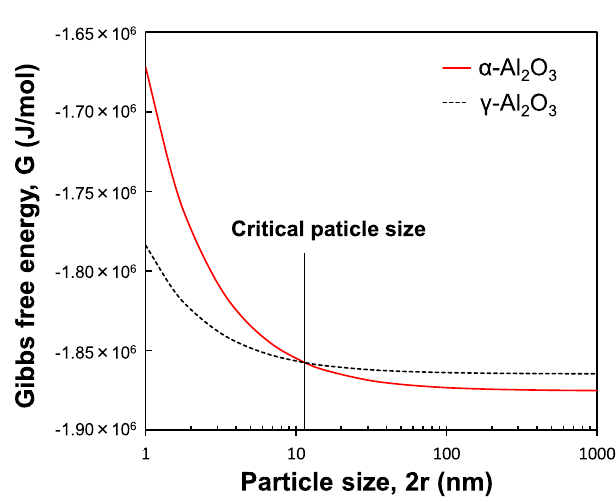
Figure 6. The relationship between Gibbs free energy, G and particle size, 2r at 1200